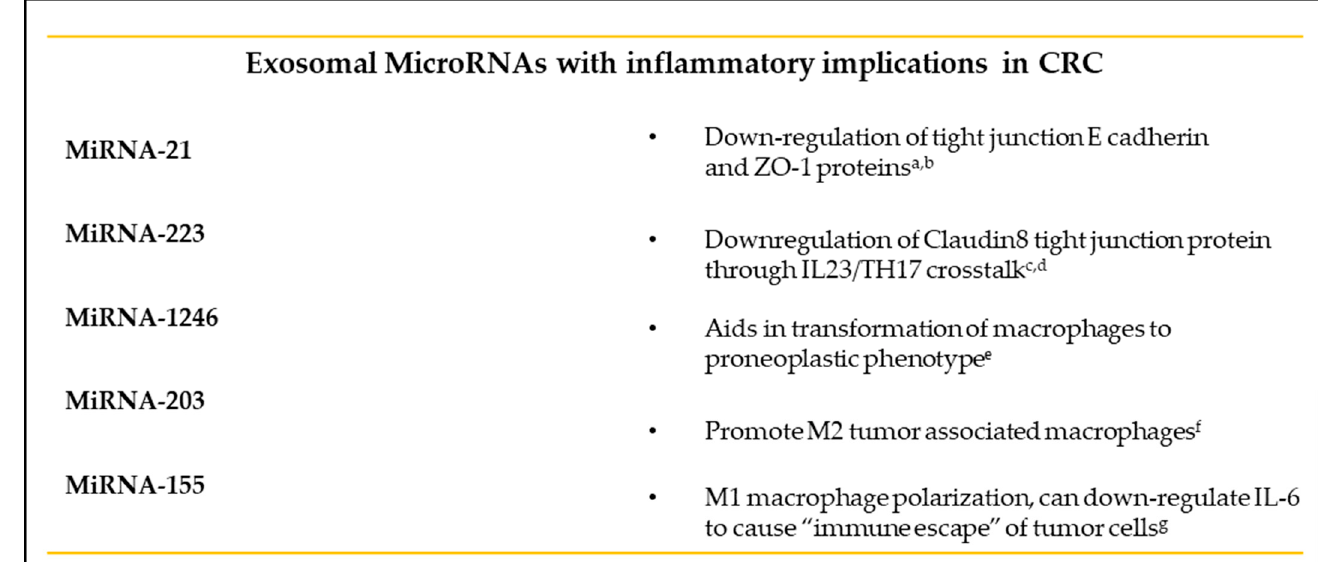
Figure 5. Exosomal microRNAs which have implications in CRC development and the various pathways and inflammatory cells which they affect. a -Zhang L et al. 2015, b -Zhang et al. 2018, c -Yuan et al. 2018, d -Wang et al. 2016, f -Takano et al. 2011, g -Ma et al. 2021